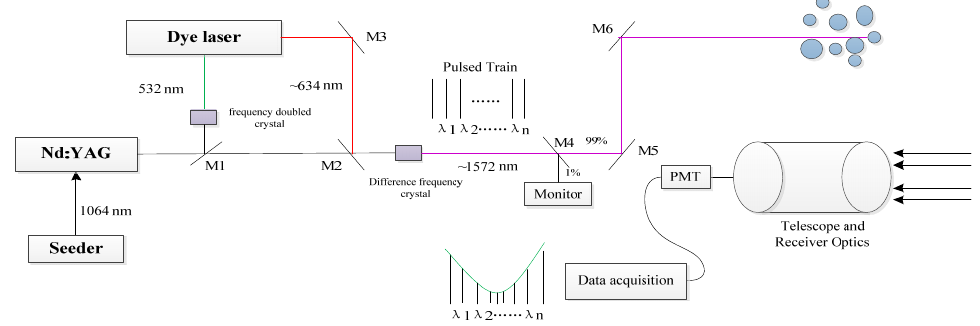
Figure 1. Block of the multi-wavelength differential absorption LIDAR (MW-DIAL) system. M1 is a semi-transmitting reflecting mirror; M2 and M4 are one-sided antireflection-coated glass devices; M3, M5, and M6 are reflecting mirrors.